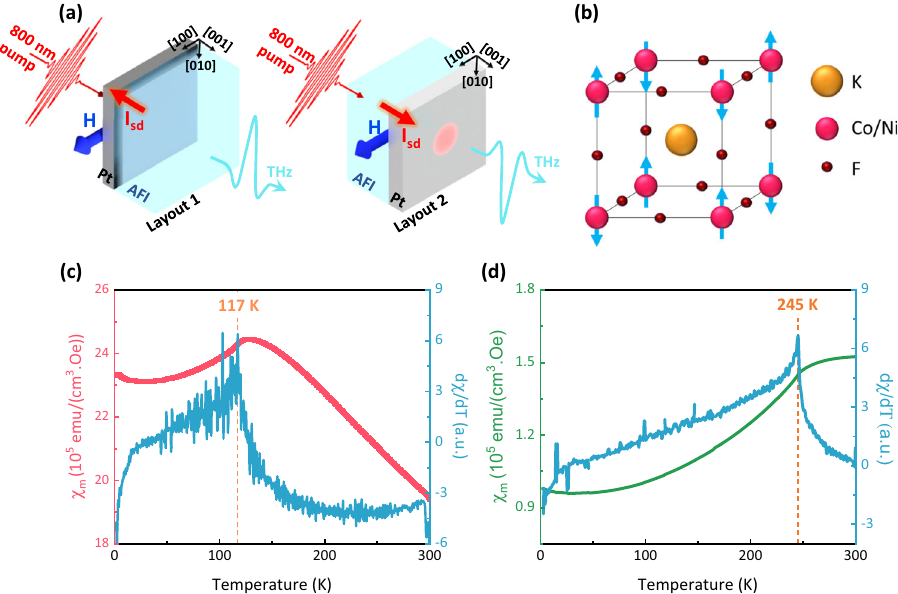
Fig.1|TerahertzemissionspectroscopyinAFI-Pt.a Schematicillustrationofthe measurement layouts. In Layout 1 the 800nm pump impinges on the sample from the Pt side and the THz emission is measured behind the antiferromagnetic insu- lator (AFI). In Layout 2 the 800nm pump impinges on the sample on the AFI side whiletheemittedTHzpulseismeasuredbehindthePt.Theexternalmagnetic fi eld